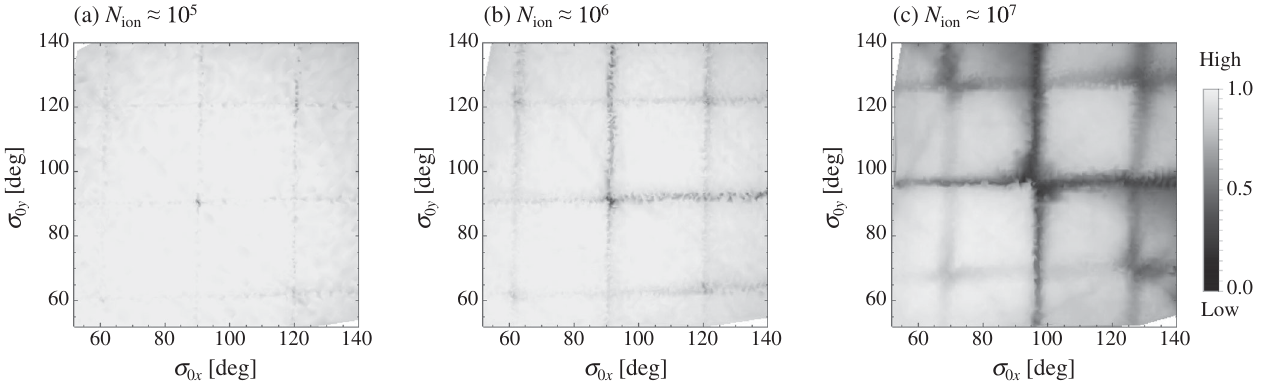
FIG. 10. Tune diagrams of the quadrupole doublet beam transport. The number of ions ( N the left picture (a), 10 6 in the middle picture (b), and 10 7 in the right picture (c). The storage period of ions in the LPT is fixed at 10 ms in all three cases. The rate of surviving ions is lower in the area of a darker shade. Each stability map is made from results of 4450 independent measurements performed with 4450 different combinations of σ 0 x and σ 0 y